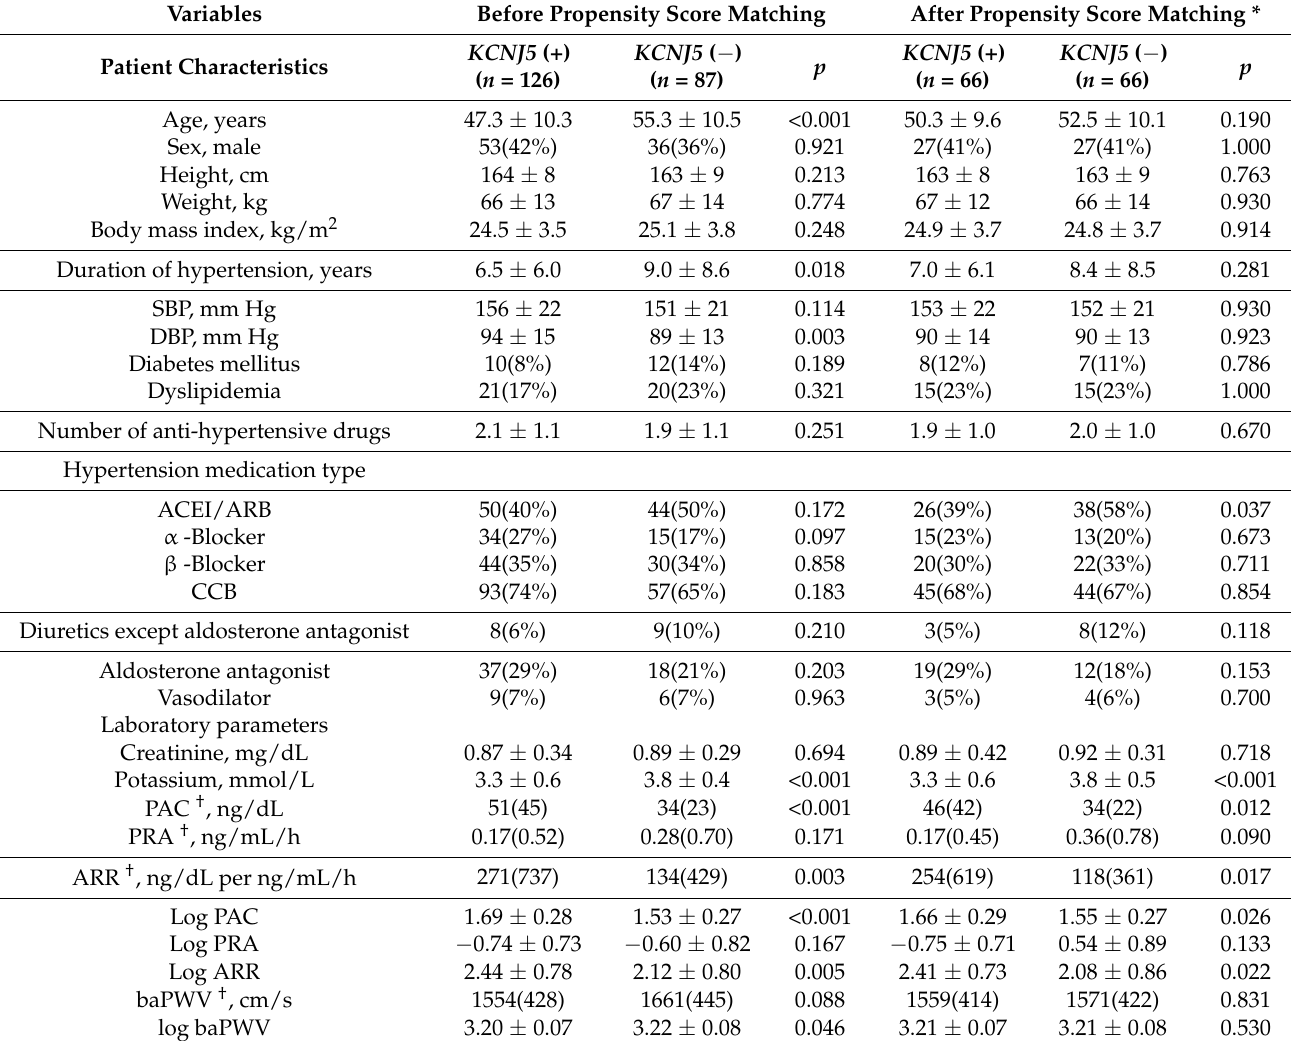
Table 1. Baseline clinical data of APA patients with and without KCNJ5 mutations before and after PSM. Variables Before Propensity Score Matching After Propensity Score Matching * Patient